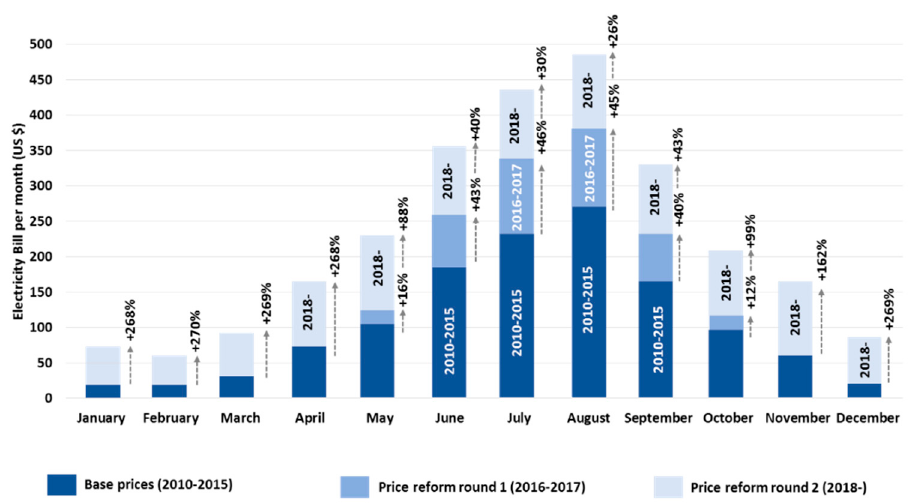
Figure 5. The effect of energy price reforms on energy bills of a typical villa. Source: Authors based on SEC.